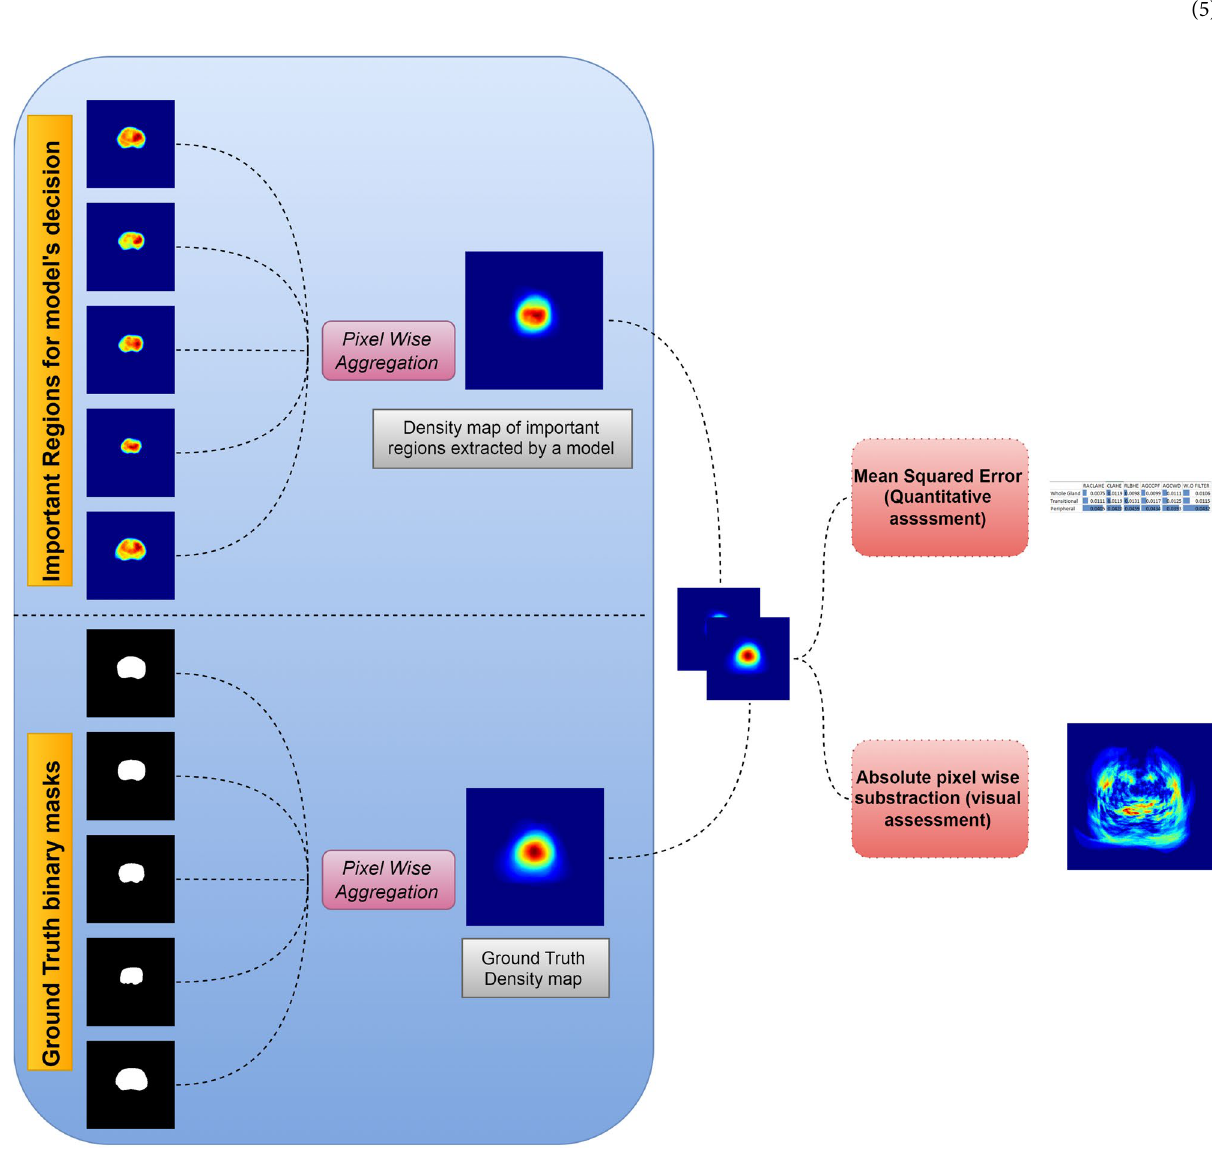
Figure 2. The explainability assessment pipeline. Density maps for GT binary masks and Feature maps are extracted via a pixel wise aggregation. Mean squared error and absolute pixel wise subtraction are performed on the density maps for quantitative and visual